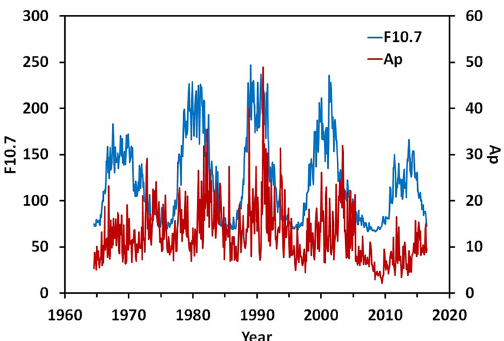
Figure 1. Monthly mean F10.7 and Ap for 1965–2016. Both indices were acquired from the National Geophysical Data Center, NGDC (ftp://ftp.ngdc.noaa.gov/STP).